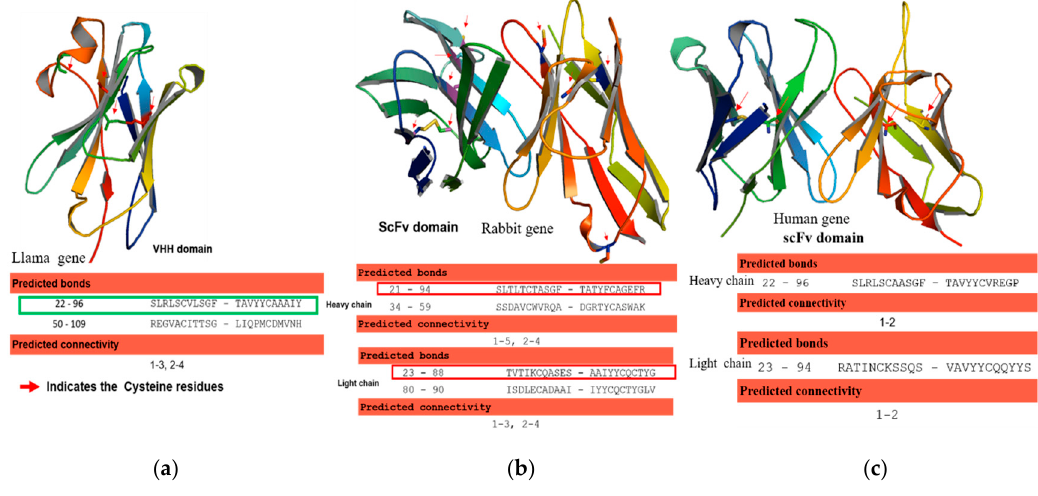
Figure 2. The schematic representation of homology structures of the antibody domain and possible canonical and noncanonical disulfide bond formation. ( a ) Homology model of camelid single-domain (VHH) llama antibody domain showing the predicted disulfide bond; ( b ) single-chain fragment variable (scFv) domain of rabbit antibody (RabscFvAb) homology model showing the number of possible disulfide bonds; ( c ) single-chain fragment variable (scFv) domain of the human antibody (humscFvAb) domain homology model showing the disulfide bonds. Red color arrows indicate the cysteine residues that are involved in the possible disulfide bonds as shown in the diagrams.